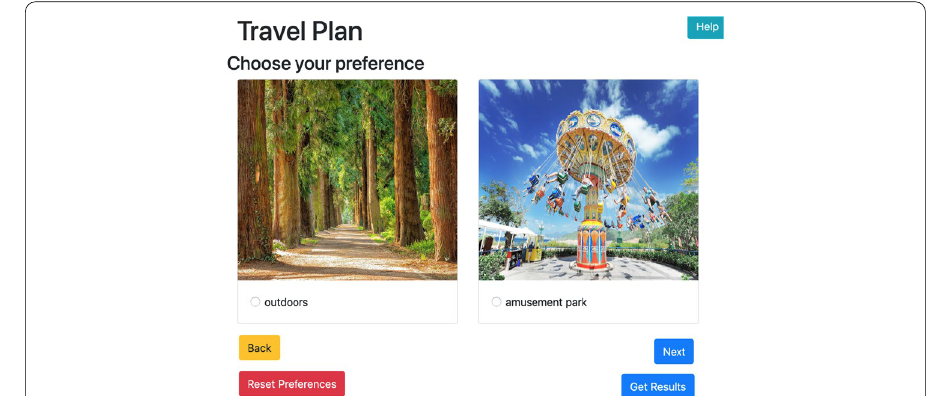
Fig. 4 UI design for user pairwise preferences